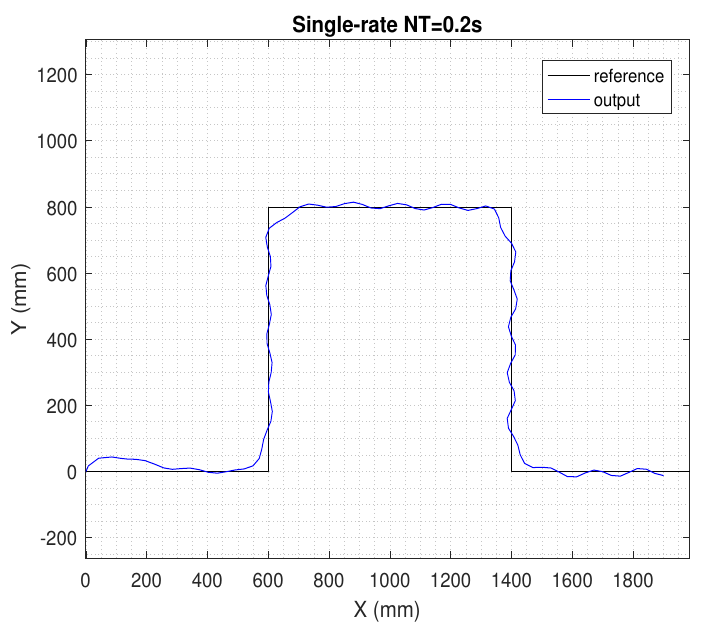
Figure 6. Results for the single-rate control at NT = 0.2 s.